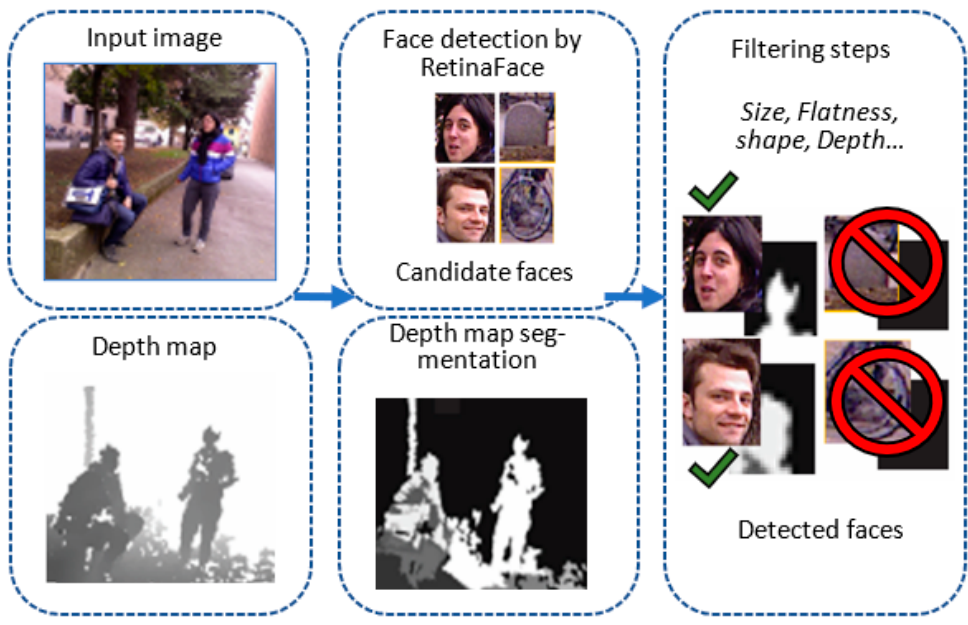
Figure 1. A general illustration of the proposed face detection approach. First, the input image undergoes a first round of detection RetinaFace ( top ). Second, segmentation is performed using the depth map of the image (bottom ). Finally, the candidate faces undergo a filtering process to select regions with faces ( right ).